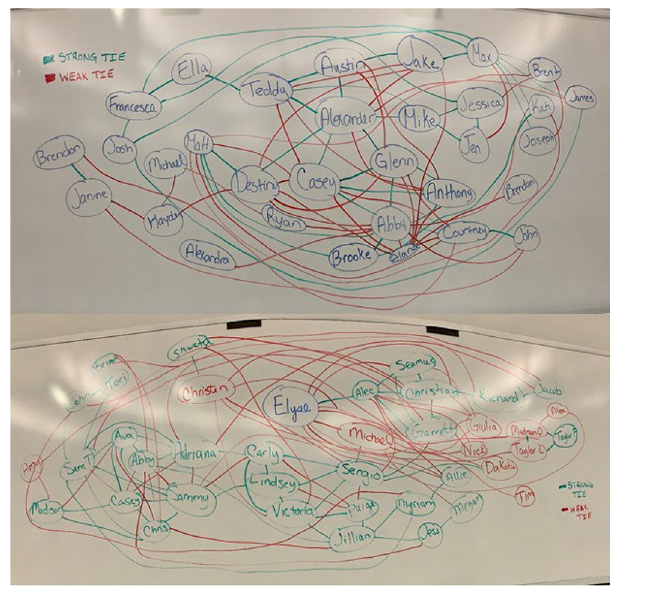
Figure 1. Examples of